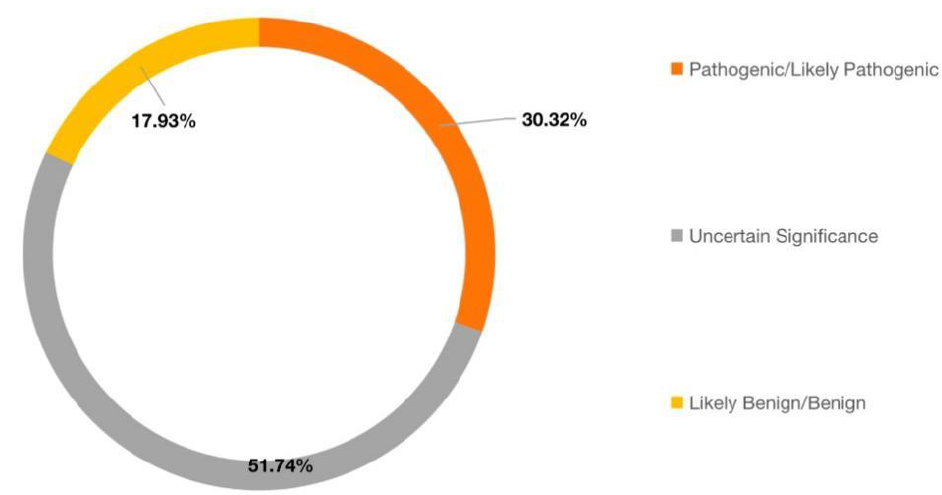
Figure 11. The distribution of pathogenicity for FH mutations in ClinVar database.